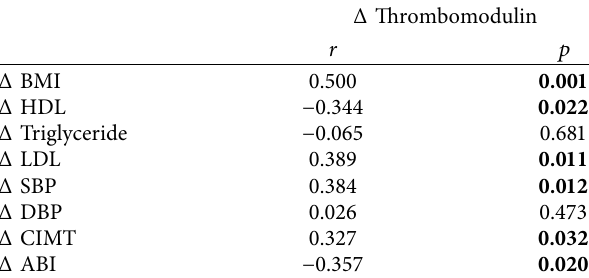
thrombomodulin, and Δ